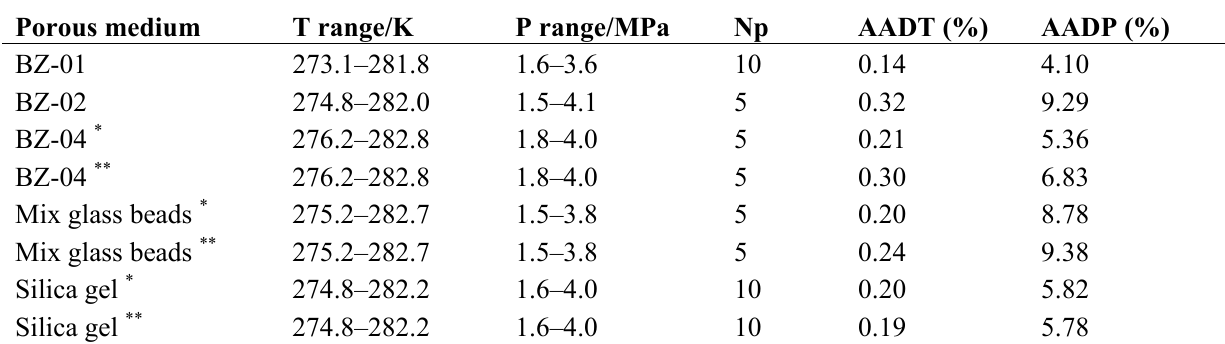
* comparison with calculation data of bulk water; ** comparison with calculation data of 1000